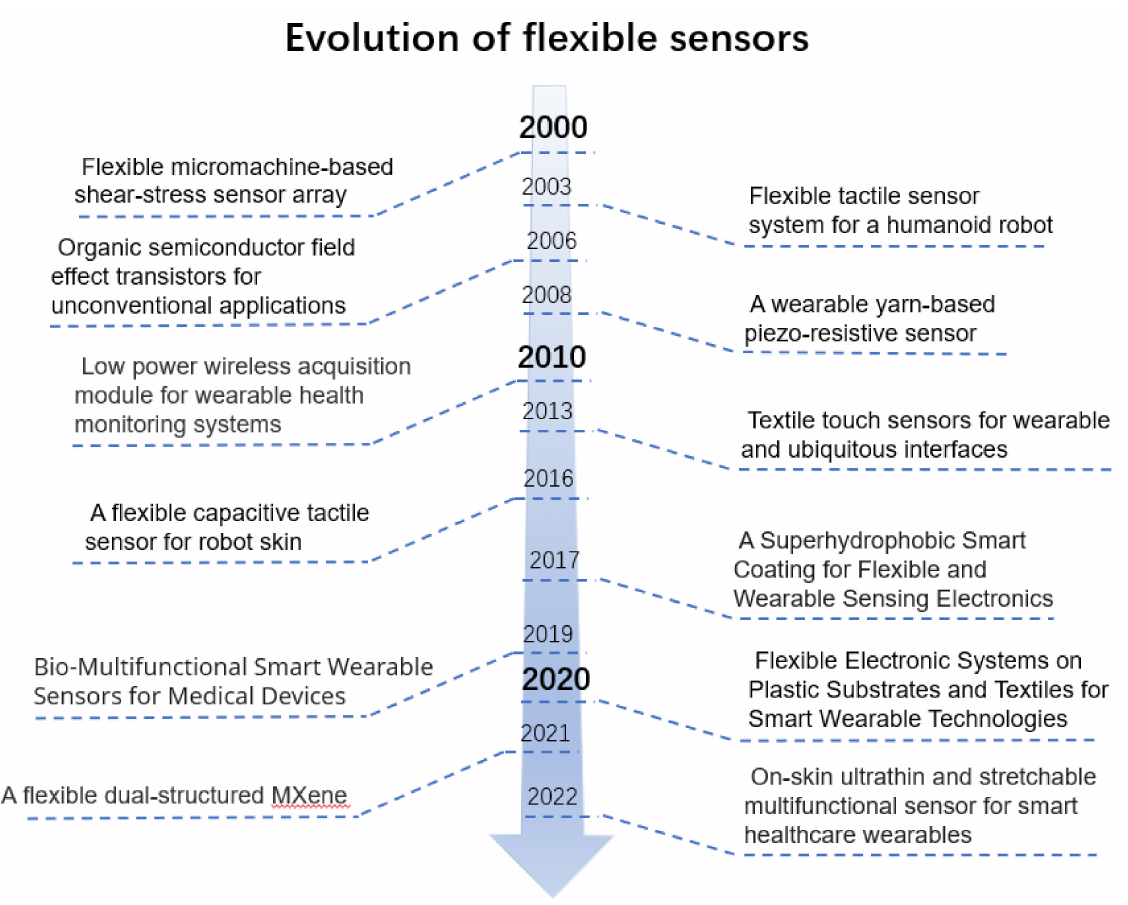
Figure 1. Timeline of the major milestones in the development of flexible sensors in the smart wearable